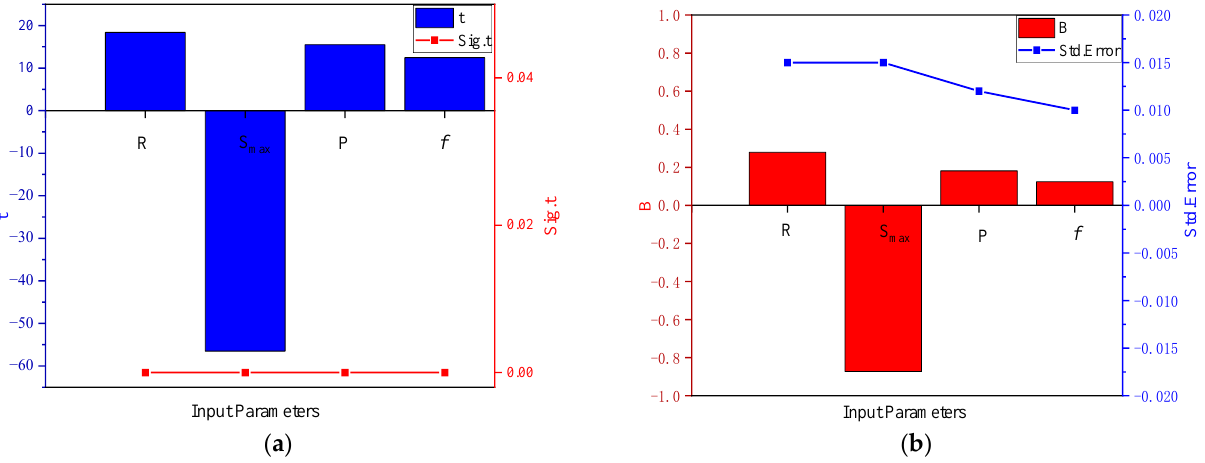
Figure 8. Analysis results from T test: ( a ) T statistic and its significance; ( b ) Partial regression coefficient and its Std.error.